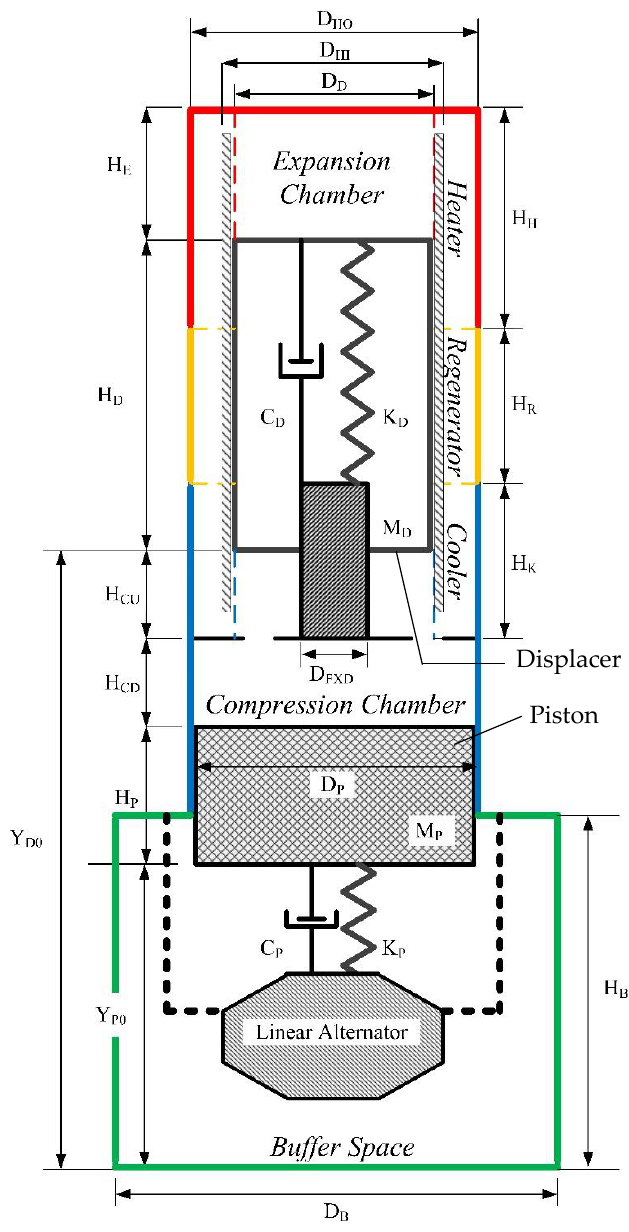
Figure 1. Diagram of a free-piston Stirling engine.